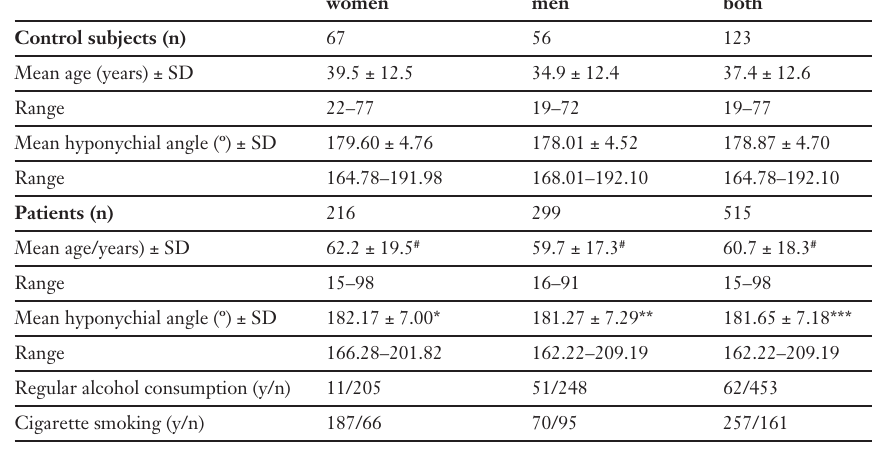
Characteristics of control subjects and